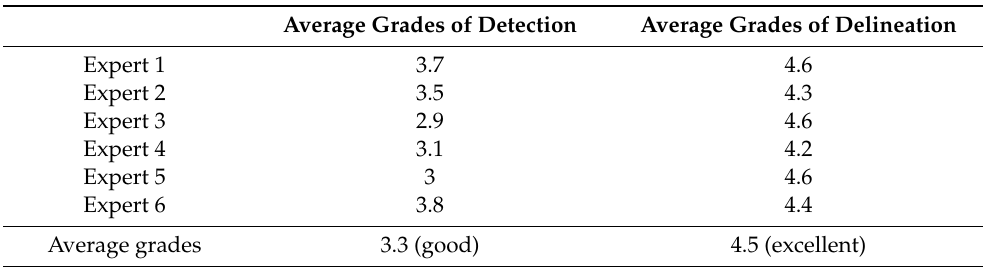
Table 6. Results from the expert-based qualitative assessment on a Mask R-CNN model (re-trained on high-resolution satellite imagery) in mapping ice-wedge polygons from ~0.5 m resolution satellite imagery, Arctic Coastal Plain, northern Alaska.